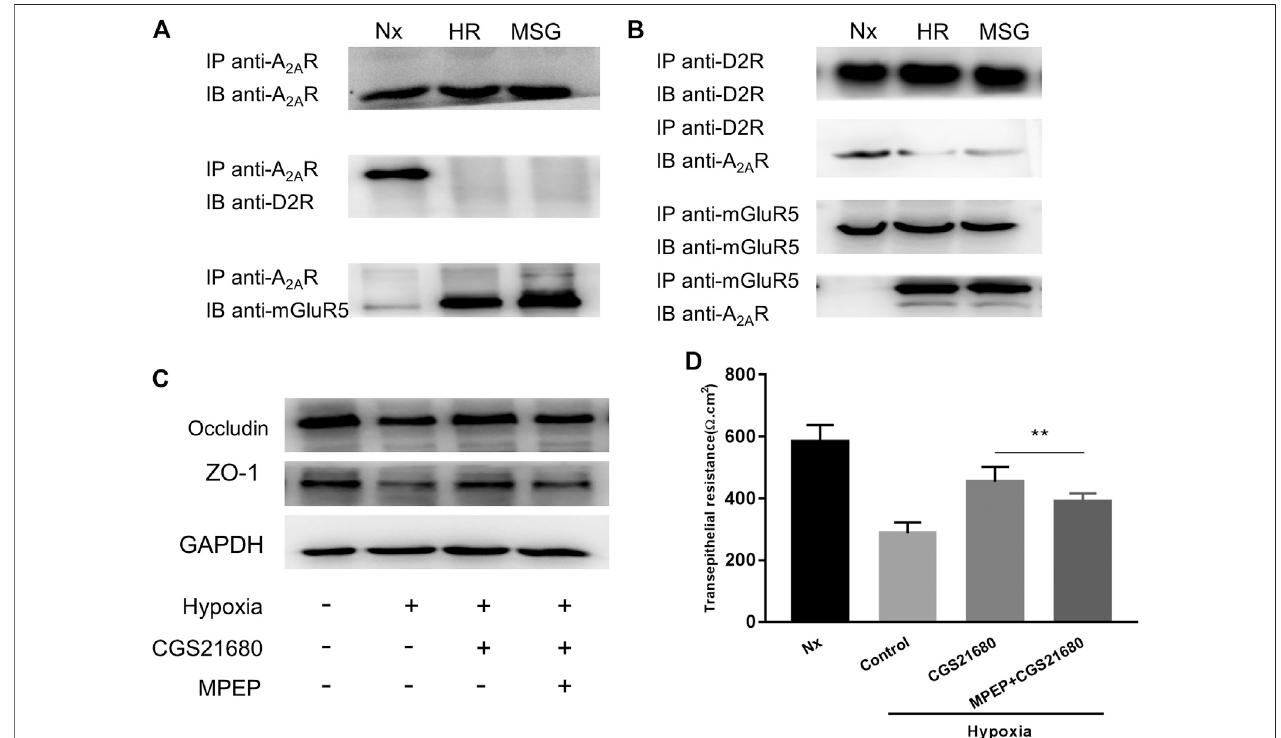
FIGURE 4 | The protective effect of A 2A R on the intestinal epithelial barrier (IEB) is mediated by combining with mGluR5. (A) Co-IP of A 2A R and D2R or mGluR5 in